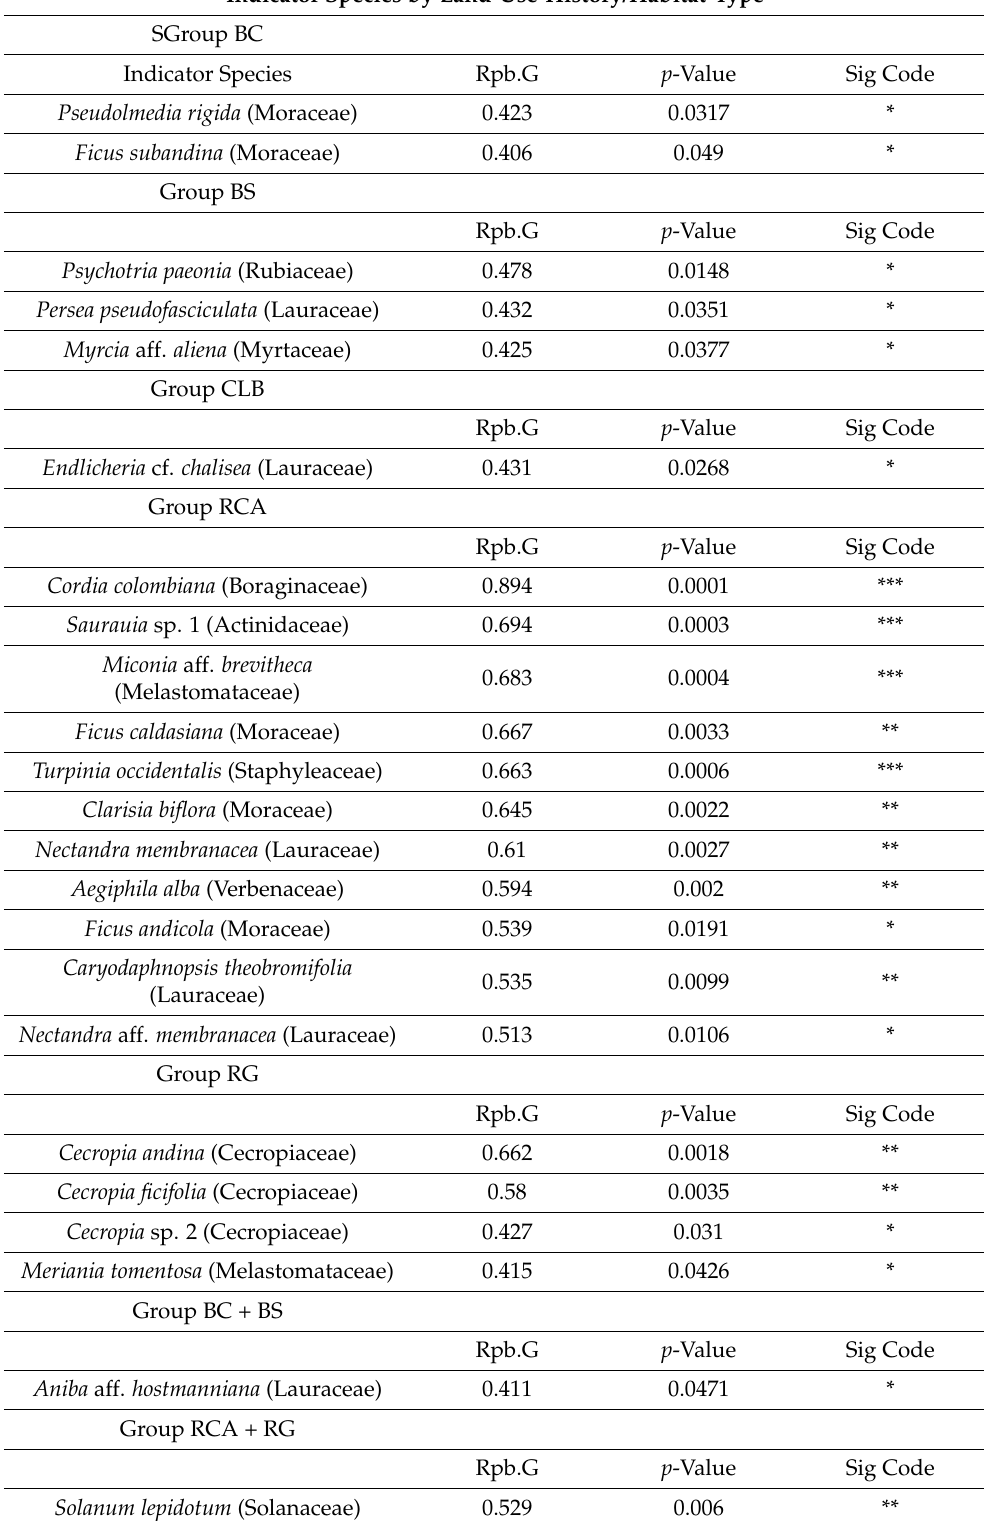
Table 4. Indicator species for historical land use/habitat, and indicator species for current ecological state (forest type). “Rpb.G” represents the point-biserial-serial-correlation-coefficient, a measure of the strength of the co-occurrence pattern observed between a tree species and a habitat-type or ecological state. Statistical significance codes: “***” p < 0.001; “**” p < 0.01; “*” p <